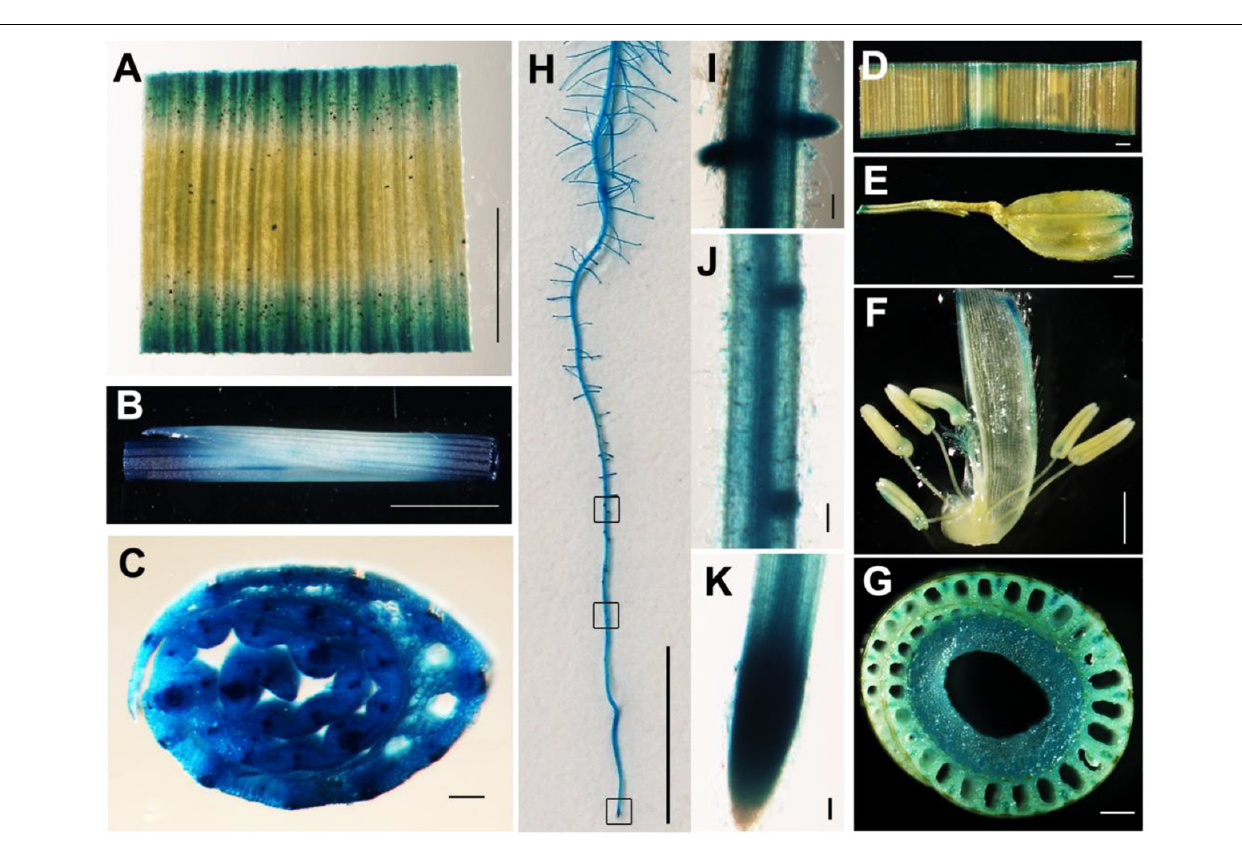
Frontiers in Plant Science |